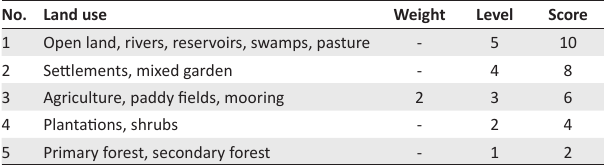
TABLE 2: Classification of land